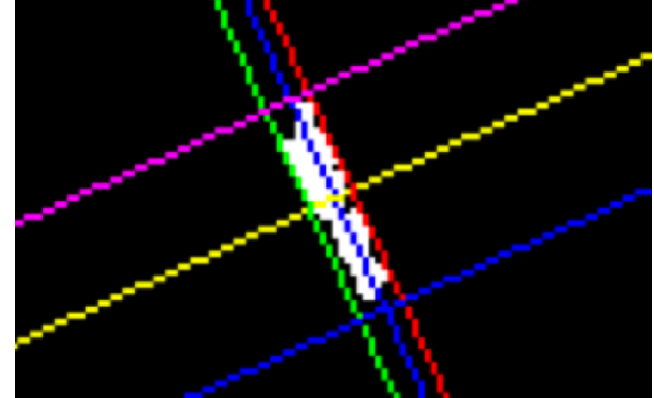
Figure 5. Ship segmentation algorithm steps.subfigure.